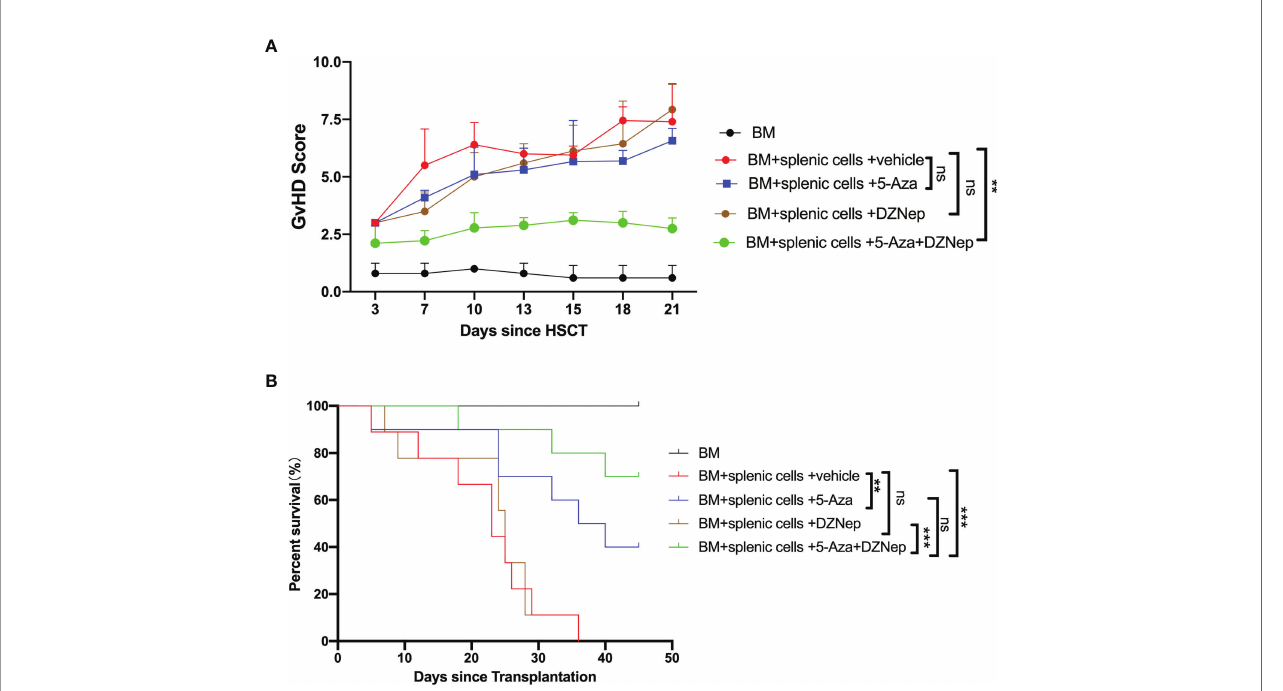
FIGURE 3 | Azacitidine (5-Aza) combined with 3-deazaneplanocin (DZNep) alleviated acute graft- versus -host disease (aGvHD). (A) GvHD score 21 days after transplantation. (B) Survival curves of each treatment group. Results were summarized from three independent experiments with 10 – 15 samples per group. Bars , mean ± SD. **P < 0.01, ***P < 0.001, ns: P >